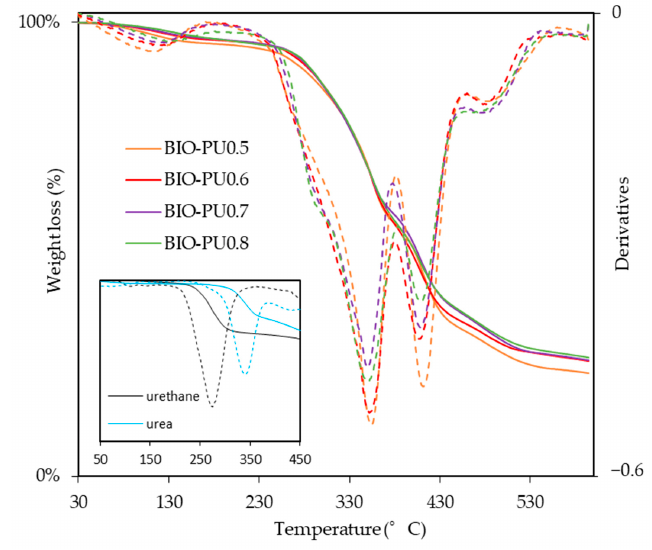
Figure 8. TG/DTG of BIO-PU films at different NCO/OH ratios. Table 3. Thermal degradation stability of BIO-PU films.